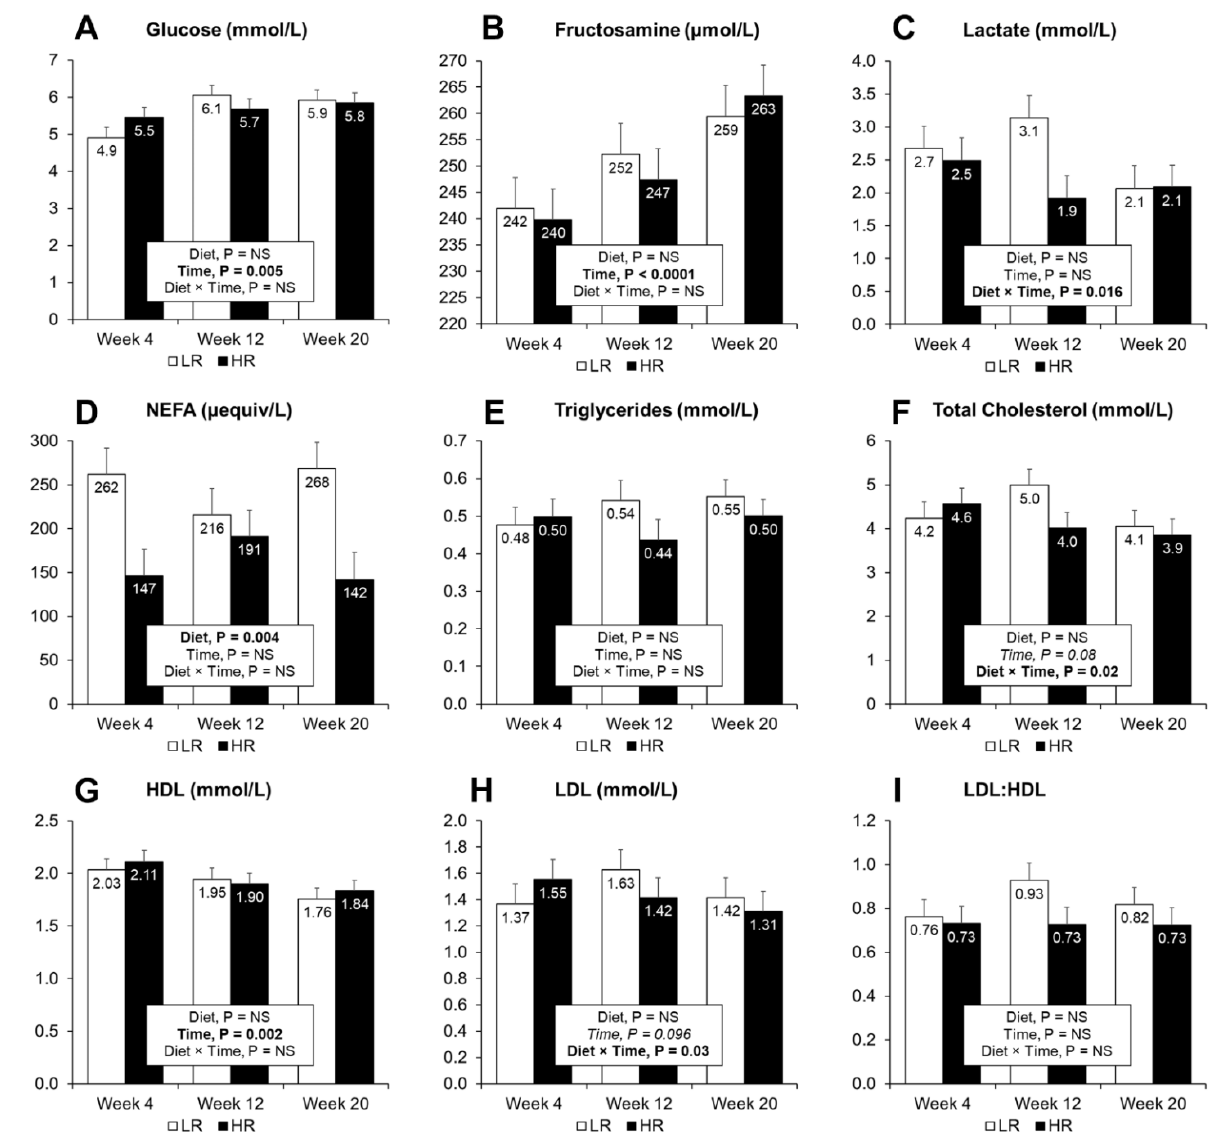
Figure 3. Plasma concentrations of biomarkers after overnight fasting. Measurements of glucose ( A ), fructosamine ( B ), lactate ( C ), NEFA ( D ), triglycerides ( E ), total cholesterol ( F ), high-density lipoprotein cholesterol ( G ), low-density lipoprotein cholesterol ( H ) and the LDL to HDL ratio ( I ), were taken at 4, 12 and 20 weeks during the dietary intervention. Results are expressed as LS means, error bars indicating SEM. NS, indicates non-significance at p > 0.05. Significant difference at p < 0.05. Table 3. Urinary concentrations of metabolites after overnight fasting.